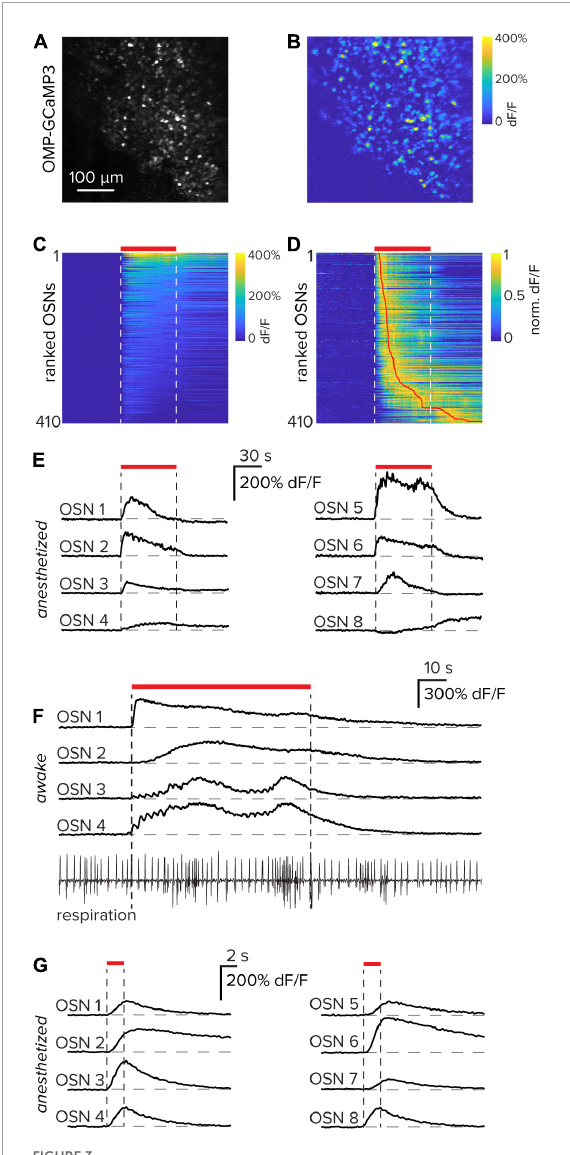
FIGURE3 Functional responses of olfactory sensory neurons through an implanted window. (A) Resting fluorescence image of olfactory sensory neurons expressing GCaMP3 in the olfactory epithelium. (B) Functional response of the entire imaging field to the odorant Methyl tiglate in an anesthetized mouse. (C) Calcium responses of 410 individual sensory neurons from the images in parts (A,B) that were significantly stimulus modulated. Vertical white dashed lines and horizontal red bar indicate the odorant delivery period. Data are sorted by their mean response in the odorant period. (D) Data in part (C) normalized to their peak and sorted by the latency to reach their peak. The vertical red line indicates the peak location. (E) Eight example sensory neuron responses collected from parts (A–D) . (F) Example functional responses collected through a thinned bone window in an awake mouse. Responses to individual respiration events, as well as respiration-frequency modulation, can be observed in some OSNs. In the respiration trace at the bottom, upward is inhalation. (G) Eight example OSN functional responses from the same imaging field using brief 2 s odorant pulses in an anesthetized mouse.